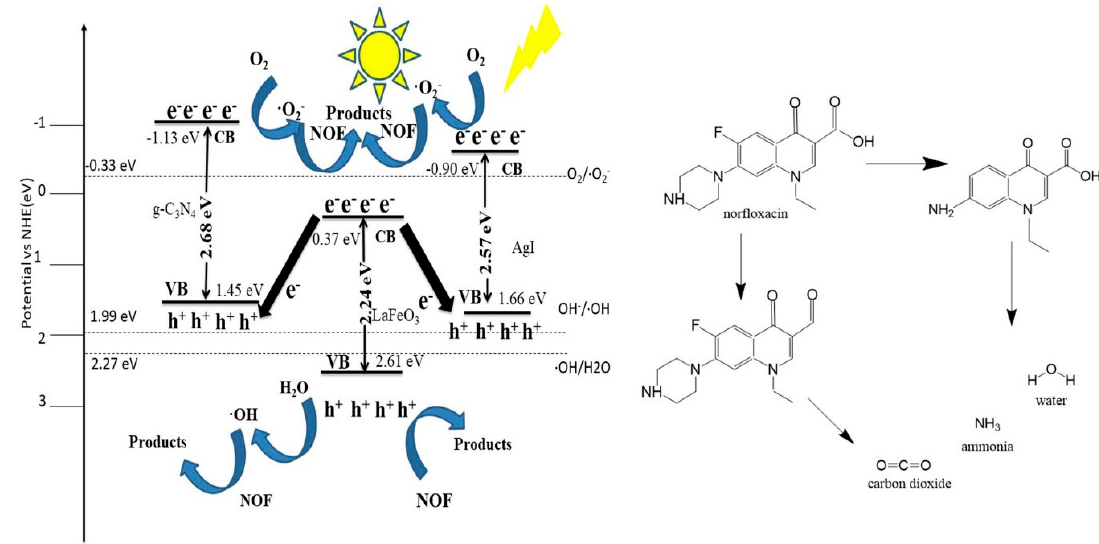
Figure 10. The structure of NOF, possible degradation pathways and possible mechanism of AgI/LaFeO 3 /g-C 3 N 4 composite photocatalyst.